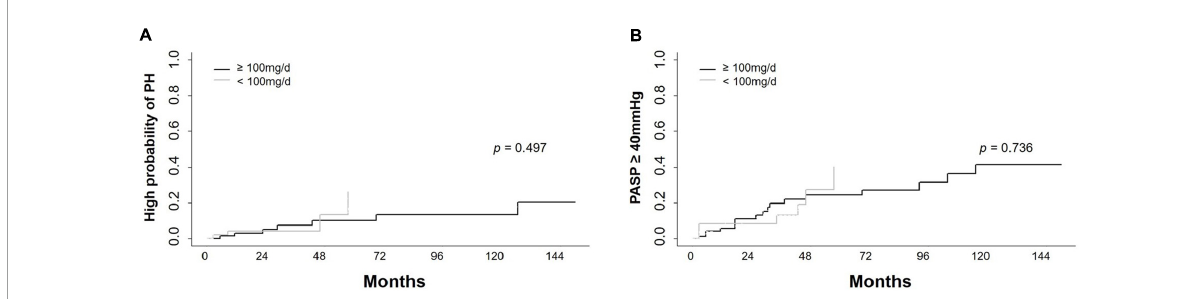
FIGURE5 Cumulative incidence of high probability of PH and PASP ≥ 40 mmHg in different dose groups. Cumulative incidence of high probability of pulmonary hypertension (PH) and PASP ≥ 40 mmHg in subjects receiving dasatinib with mean dose < 100 mg/d and ≥ 100 mg/d showed no significant difference . (A) Cumulative incidence of high probability of PH in longitudinal cohort. (B) Cumulative incidence of PASP ≥ 40 mmHg in longitudinal